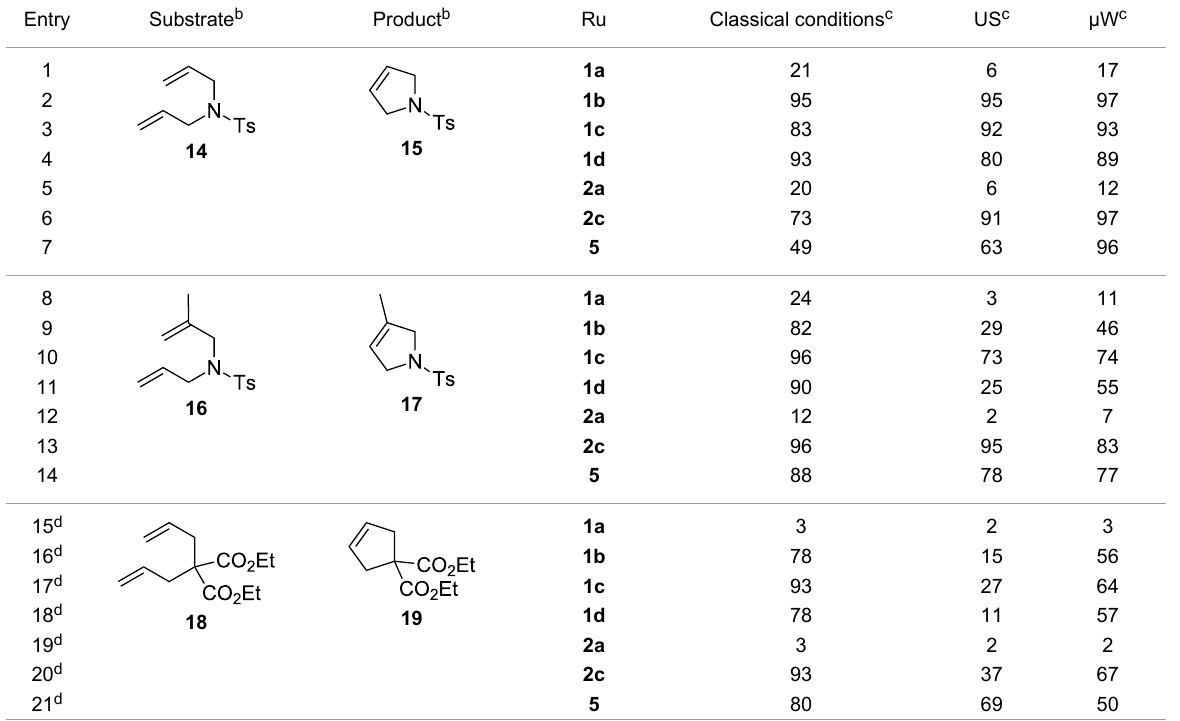
Entry Substrate b Product b Ru Classical conditions